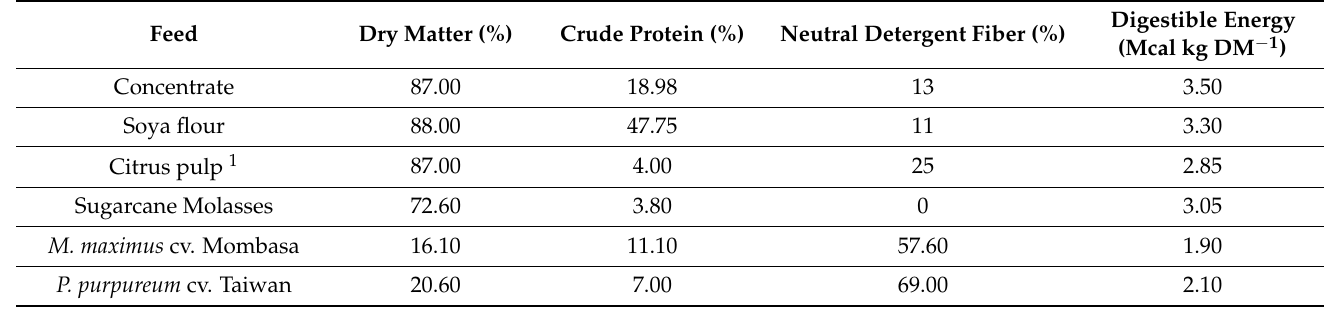
Table 1. Dry matter (DM) content and chemical composition of the supplements used in cows.